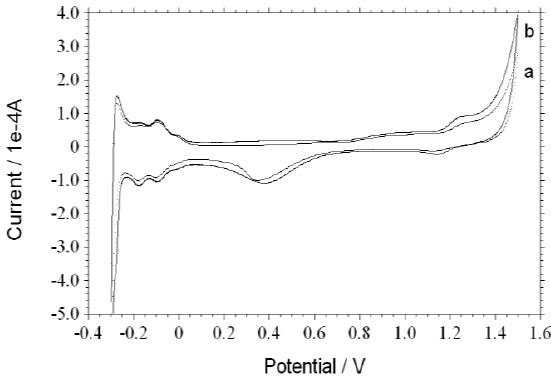
Figure 3. Cyclic voltammetry (CV) curves of Pt/ND ( a ) and Pt/ZrO 2 /ND ( b ) electrodes in 0.5 mol/L H 2 SO 4 .